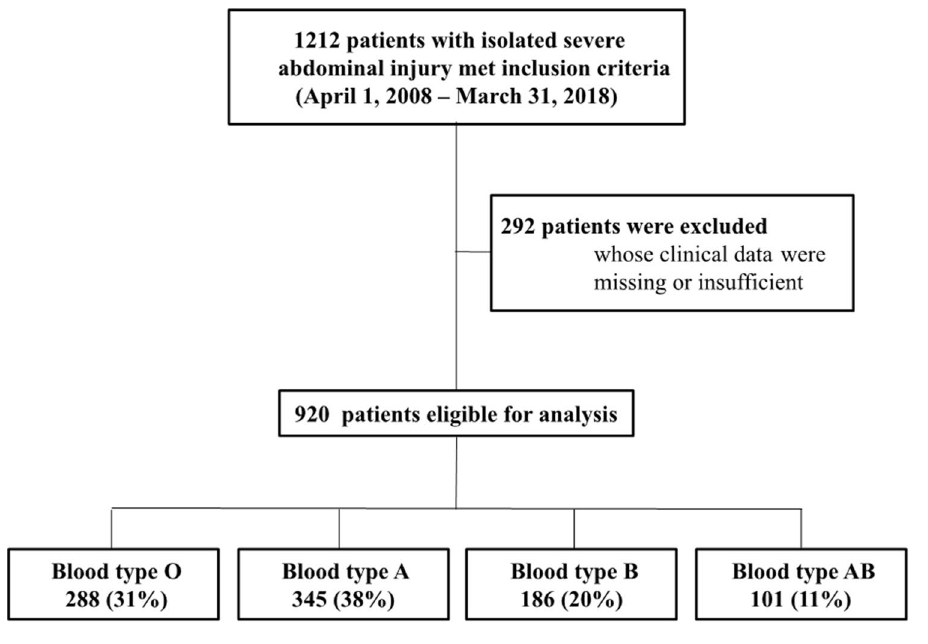
Figure 1. Patient flow